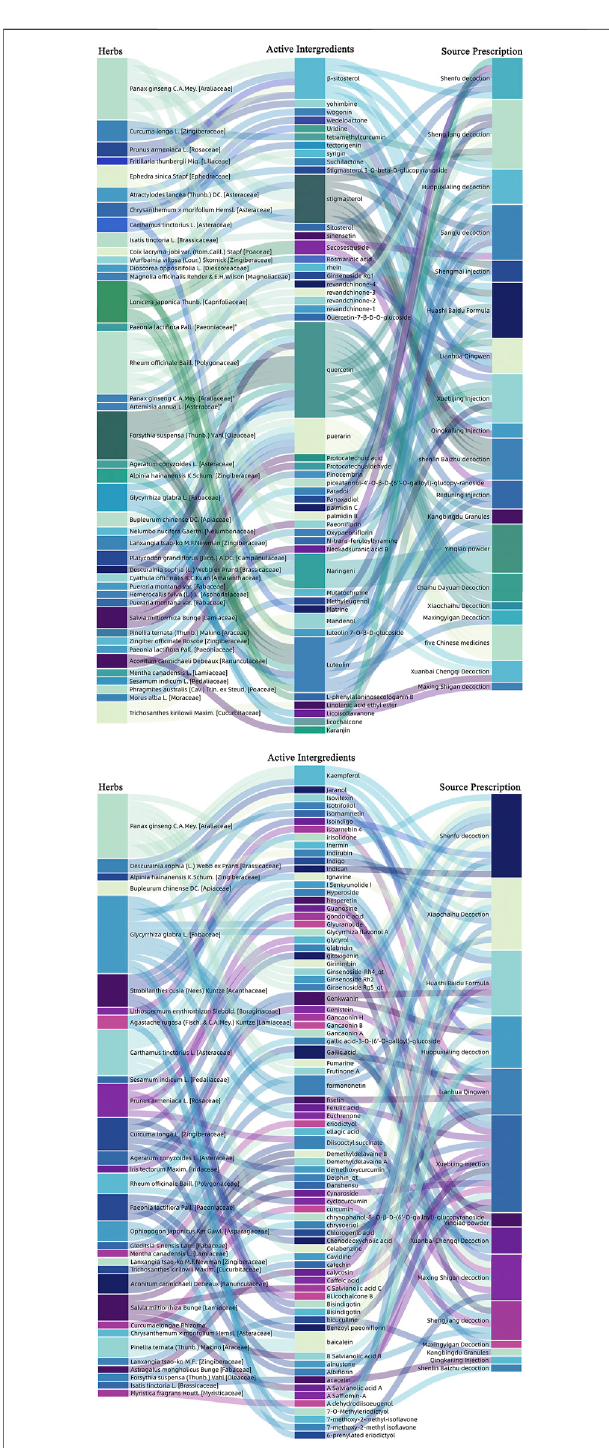
FIGURE 3 | Herbs with potential ACE2 receptor blockers, as well as related active ingredients and derivative prescriptions. We analyzed the most commonly used Chinese medicine prescriptions in the “ Diagnosis and Treatment Protocol for Novel Coronavirus Pneumonia. ” Herbal medicines with potential ACE2 receptor blockers and related active ingredients have been sorted